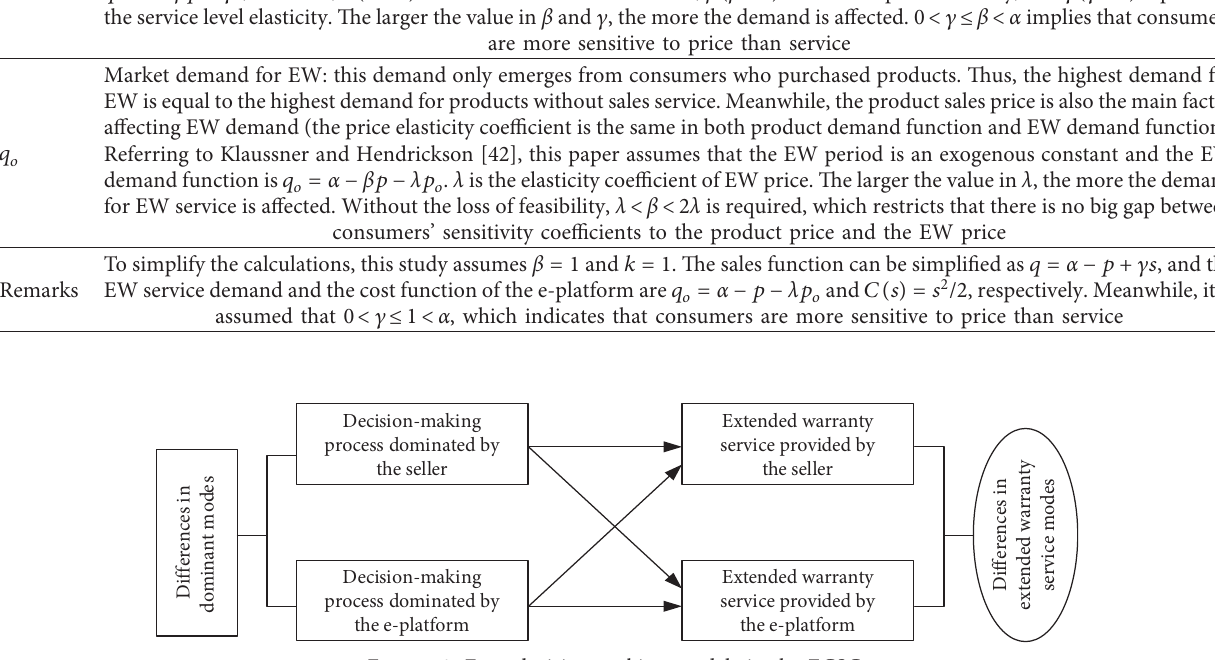
Figure 2: Four decision-making models in the